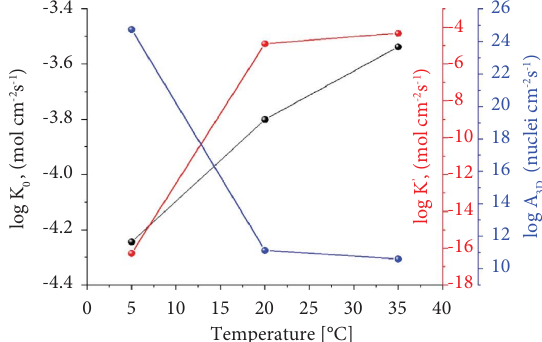
Figure 4: Dependence of log( k for lead (II) on